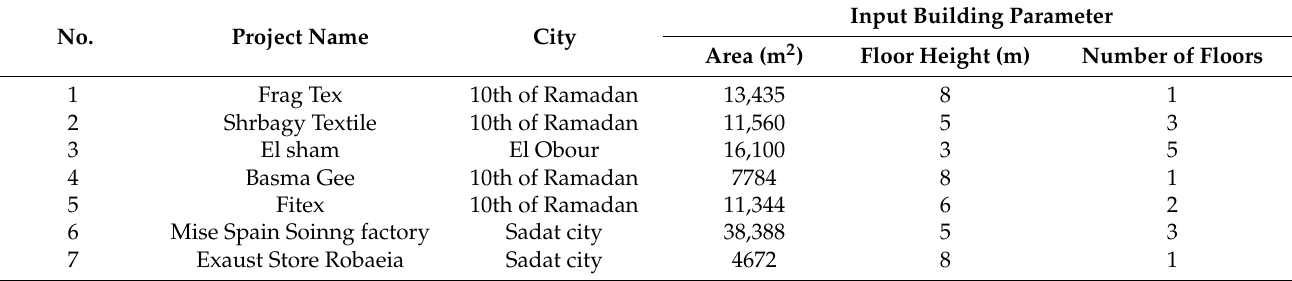
Table 4. Data collection of the seven case